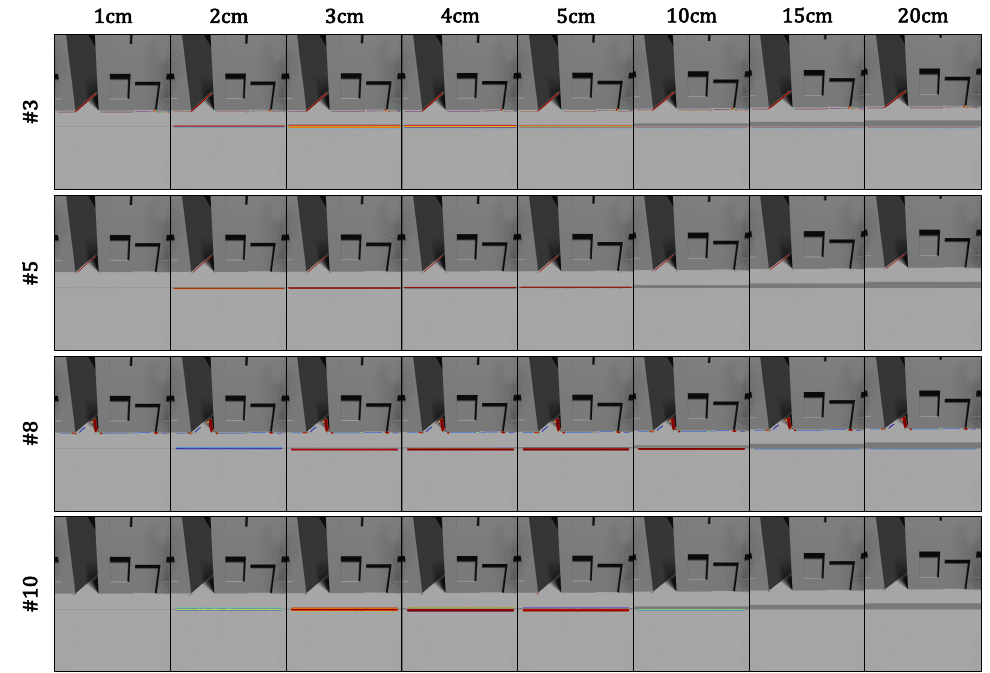
Figure 13. Illustration of how high a difference in level can be